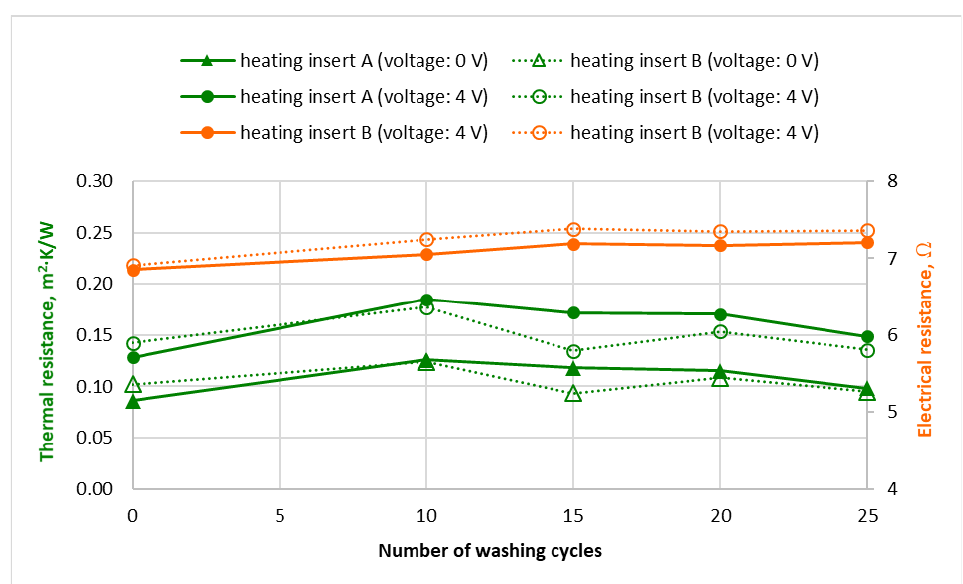
Figure 11. Thermal resistance of fabric systems with a heating insert depending on the number of washing cycles.